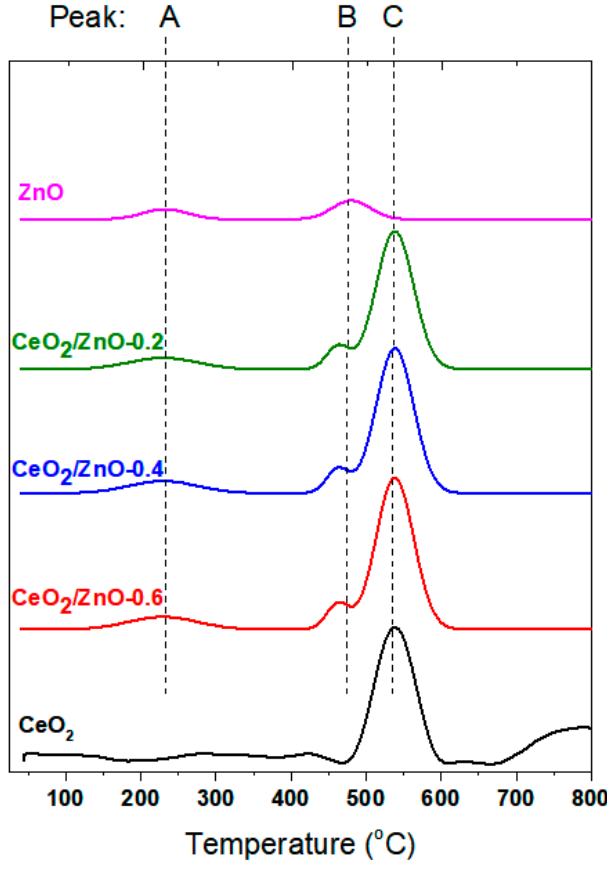
Figure 5. H 2 -TPR profiles of CeO 2 and the CeO 2 /ZnO samples.